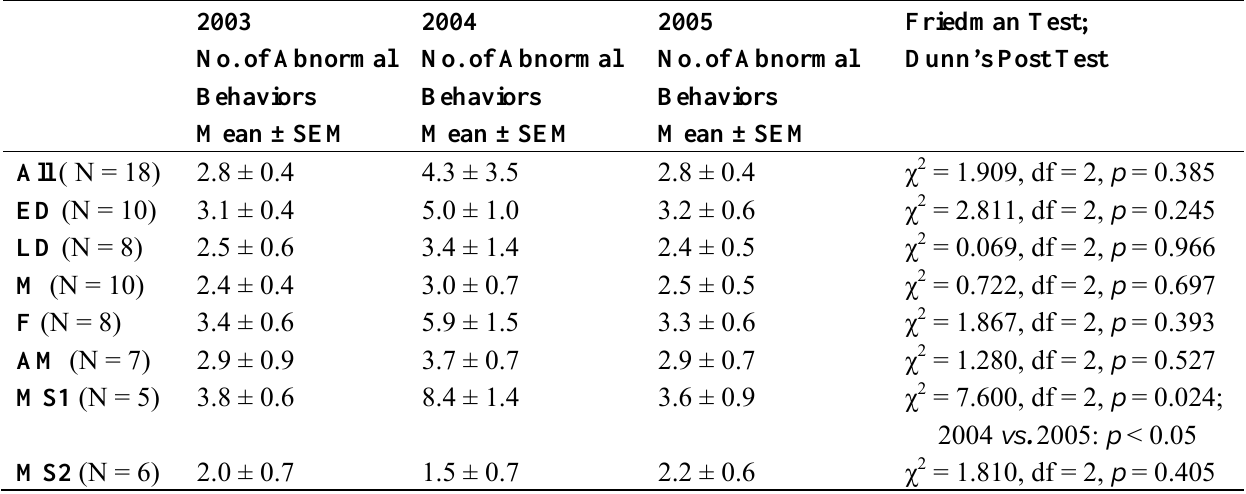
Table 5. Comparison of the diversity, i.e. , the mean number of abnormal behaviors, over the three sample periods (2003 to